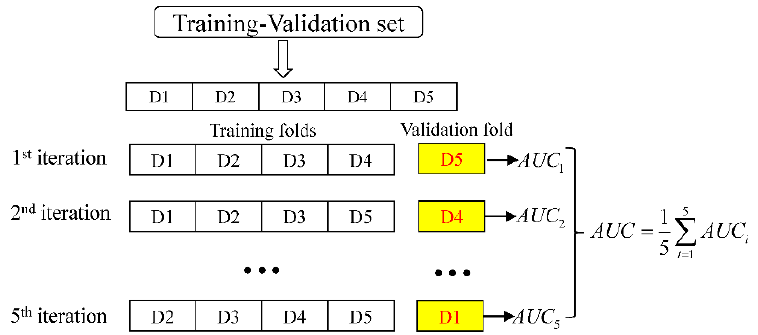
Figure 5. Schematic diagram of 5-fold CV.